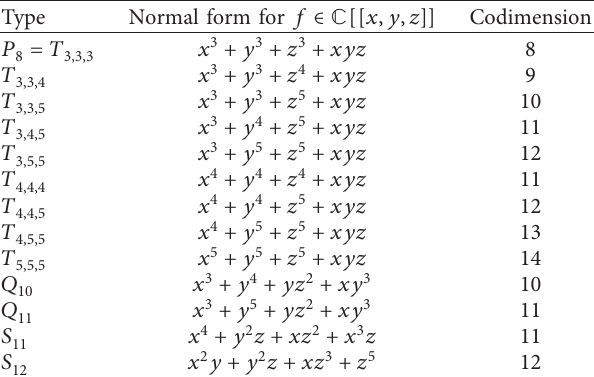
Table 2: Lipschitz simple function germs of corank